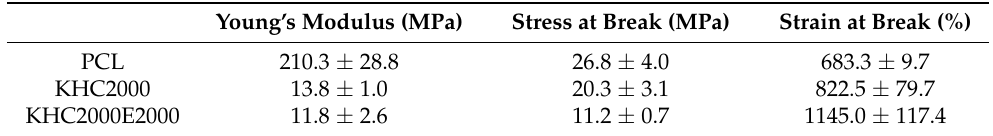
Table 2. Mechanical properties of PCL, KHC2000, and KHC2000E2000.